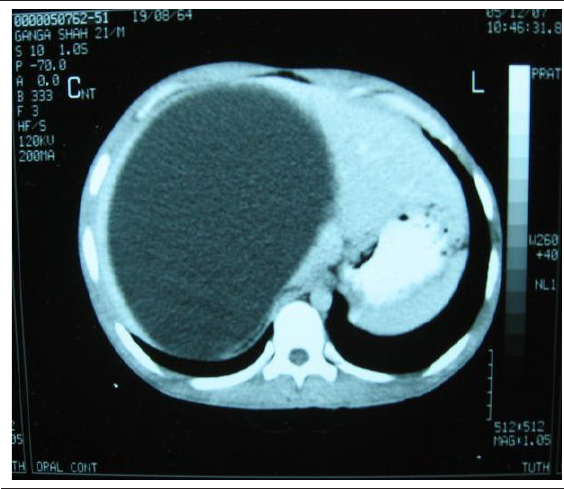
figure 2. ct abdomen showing cyst arising from the liver. On exploration through extended right sub costal incision, diagnosis of giant right sided hydronephrotic kidney due